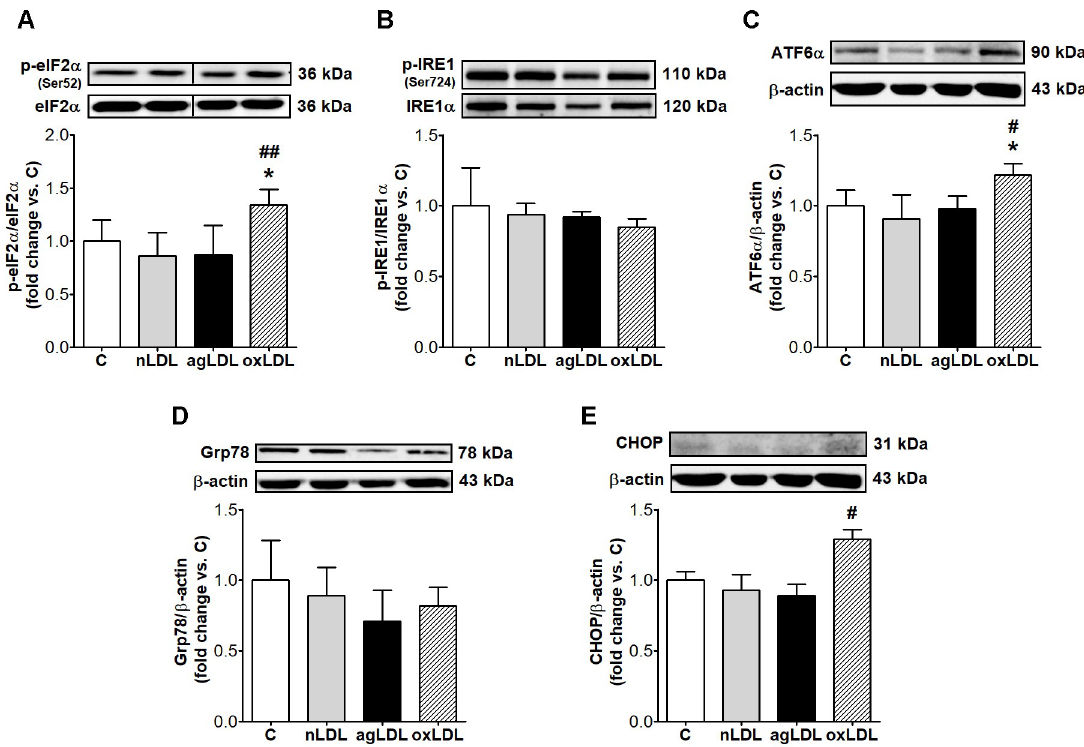
Fig 5. AgLDL do not trigger ER stress in THP-1 macrophages. Cells were exposed for 24 h to 100 μ g/ml aggregated LDL (agLDL), oxidized LDL (oxLDL) or native LDL (nLDL). Cells incubated in the same conditions without LDL were considered control cells (C). Representative blots and densitometric analysis of phospho-eIF2 α (p-eIF2 α ) normalized to total eIF2 α (t-eIF2 α ) (n = 3) (A), phospho- IRE1 (p-IRE1) normalized to IRE1 α (n = 4) (B), ATF6 α (n = 4) (D), Grp78 (n = 3) (E) and CHOP (n = 4) (F) protein normalized to β - actin. All data are expressed as fold change versus C and presented as mean ± SD. � p < 0.05 vs. C; # p < 0.05, ## p < 0.01 vs. nLDL.